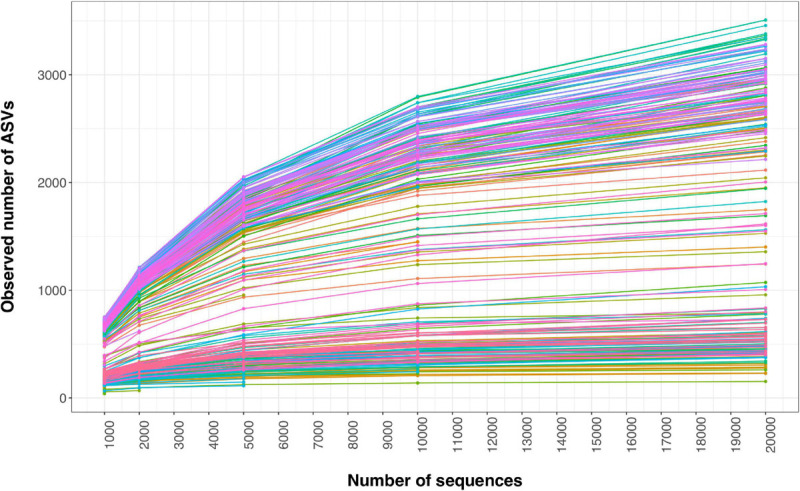
Rarefaction curves of the phyllosphere and soil bacterial ASVs. Rarefaction curves are shown for all the phyllosphere and soil samples according to the observed ASVs richness. Each line and color represent one sample. The sequencing coverage (x-axis: number of sequences) is 20,000 reads with cutoffs at 1,000, 2,000, 5,000, and 10,000 reads.